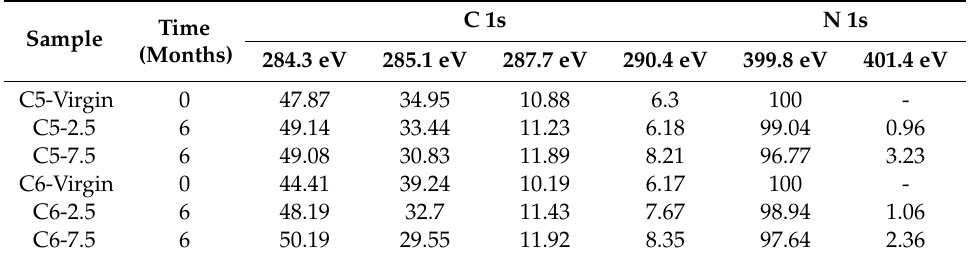
Table 5. The narrow scans of carbon (C1s) and nitrogen (N1s) of the RO membranes prior and after 6 months to exposure to the acid solutions by